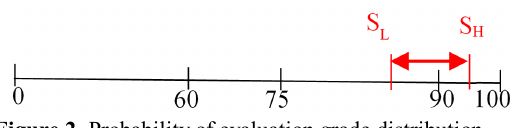
Figure 2. Probability of evaluation grade distribution